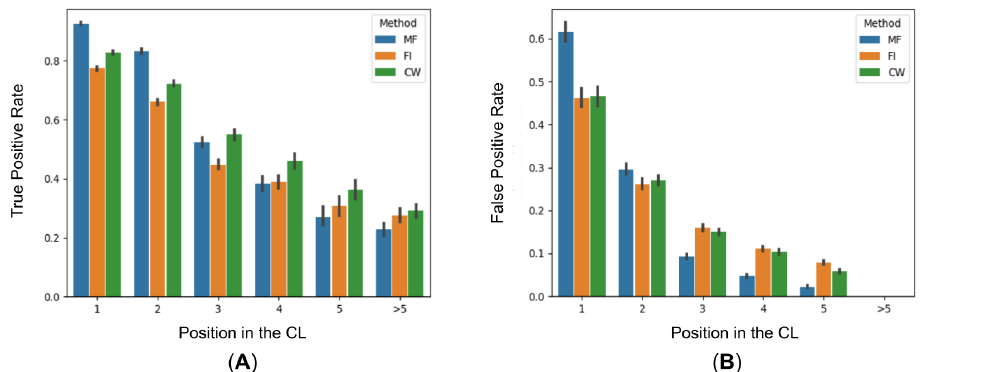
Figure 3. TPR ( A ) and FPR ( B ) comparison for MF, FI and CW heuristics. The first five positions in the CL are considered separately, while all the others are shown in the >5 bars.